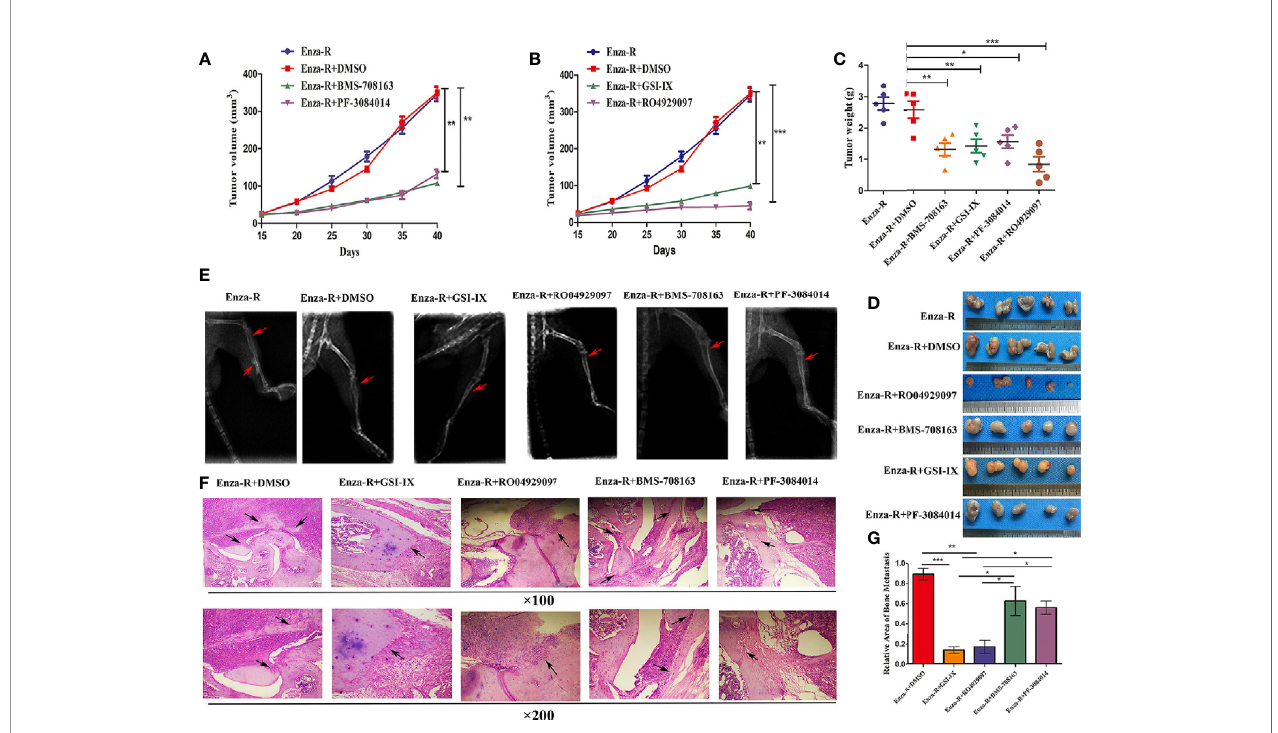
FIGURE 7 | The combination of g -secretase inhibitors and enzalutamide suppressed growth and bone metastasis of Enza-R cells in vivo . The nude mice with subcutaneous or bone xenograft were respectively treated 10 mg/kg enzalutamide and 50 mg/kg various g -secretase inhibitors. (A, B) Tumor growth curve (C) Weight of tumors (D) Images of the recovered tumors (E) X-ray for bone metastasis (F) H&E staining for bone metastasis (upper×100, lower ×200). (G) The quantitative results of bone metastasis based on bone metastasis. *P < 0.05, **P < 0.01, ***P <